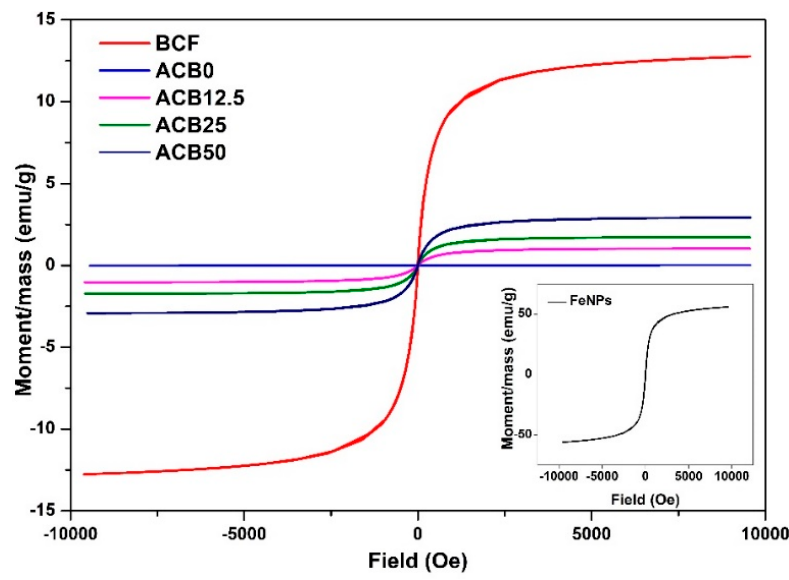
Figure 7. Magnetization curves for ACB hydrogels.